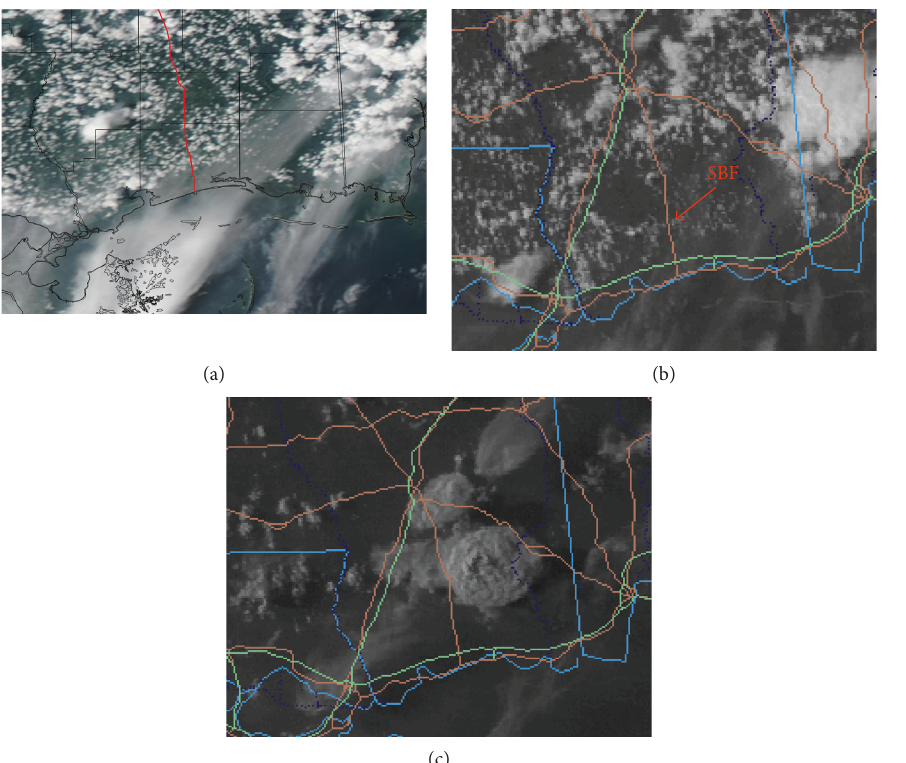
Figure 3: Visible imagery on 5 August 2014. (a) MODIS Aqua at 1835 UTC (1335 CDT). (b) GOES at time that the transect intersected the SBF (2000 UTC; 1500 CDT). (c) GOES at 2330 UTC (1830